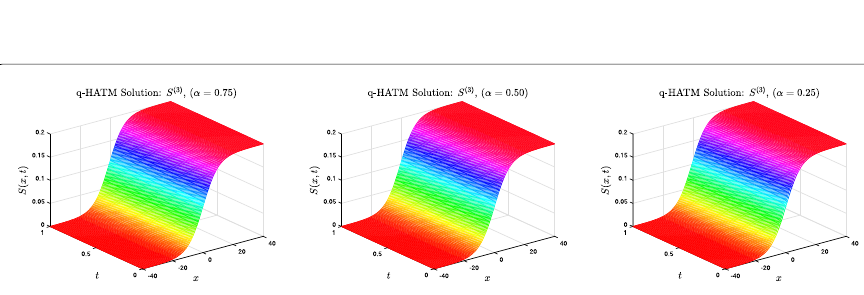
Figure 10 q-HATM S (3) -solution with different α when (cid:2) = –1, k = r = 0.1, λ = 1.5, and n = 1 for Example